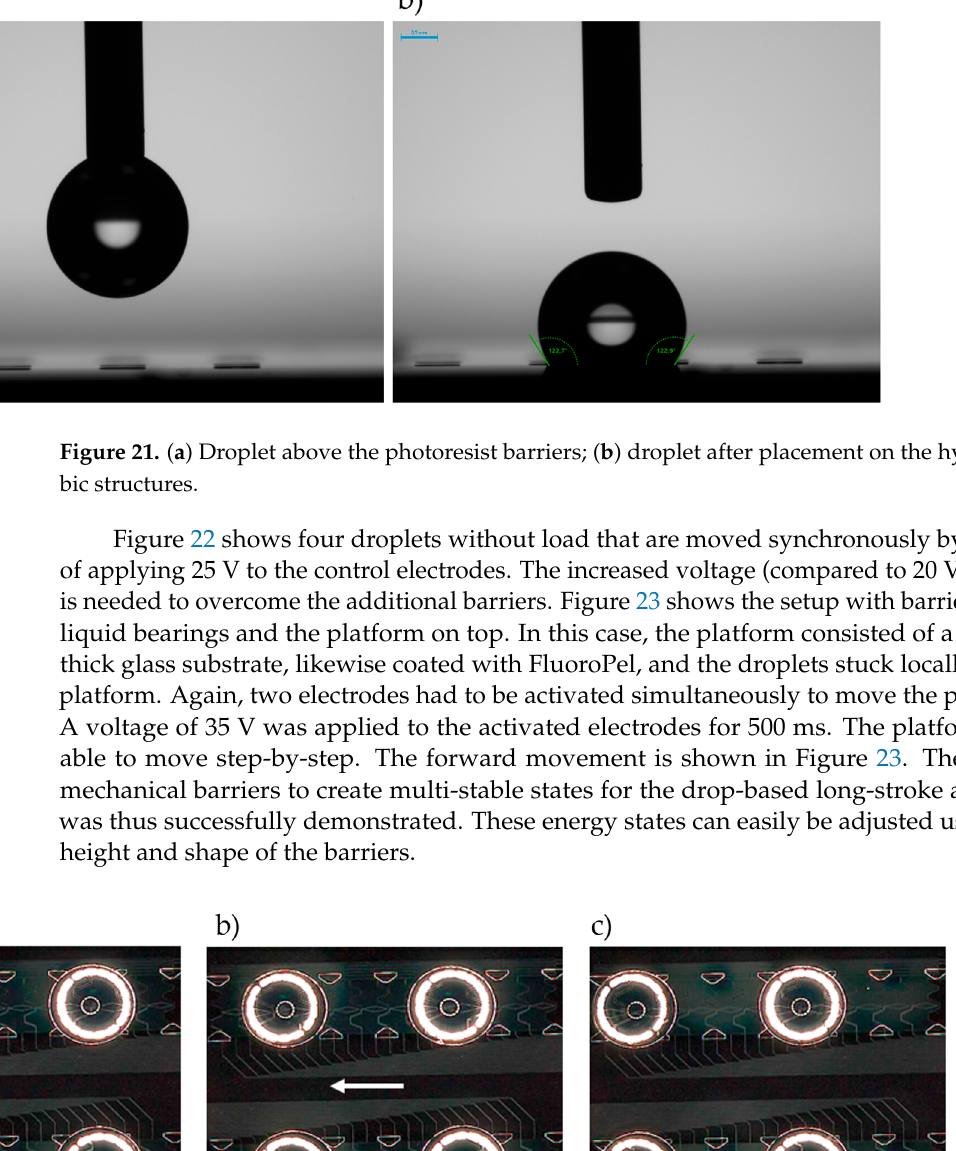
Figure 20. Physical photoresist barriers with a height of approximately 9 µm. Neither the fi ve seg- mented fi nger electrodes to the side nor the electrodes in the center of the structure are relevant for the long stroke actuation.